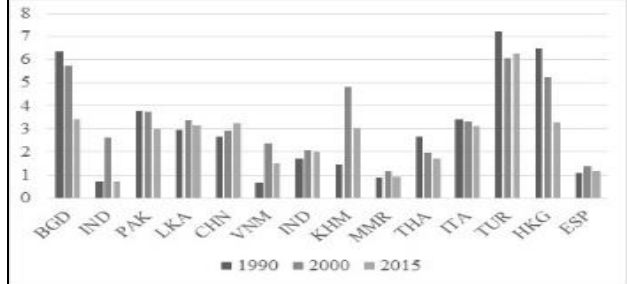
Figure 3: Revealed comparative advantage (RCA) of selected economies; Source: